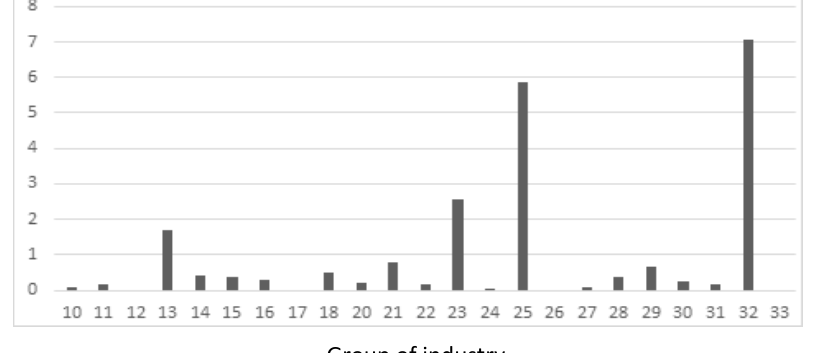
Figure 4: Percentage of MSIs involved in Export by Group of Industry,